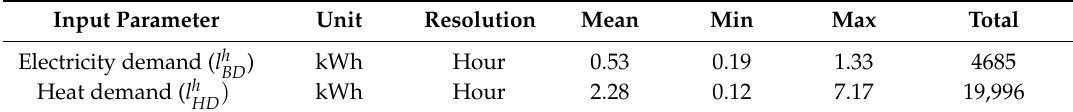
Table 3. Descriptive statistics of the households’ demand time